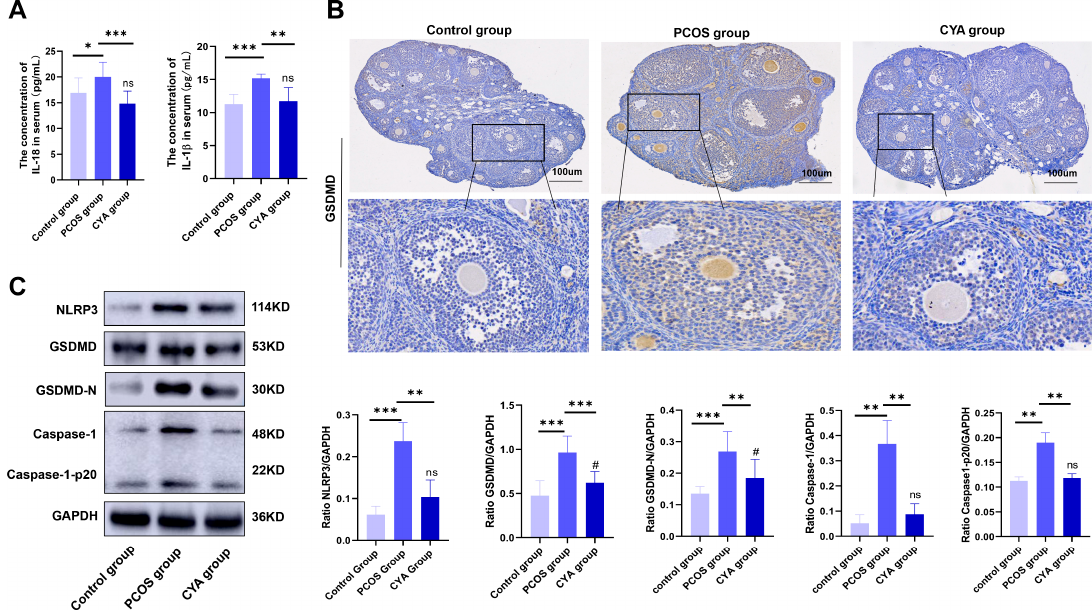
Figure 3. CYA can effectively alleviate the expression of inflammatory factors and ovarian GC pyroptosis-related proteins in PCOS mice induced by hyperandrogen. ( a ) The expression of IL-18 and IL-1 β in serum was analyzed with enzyme-linked immunosorbent assay kits in the three groups of mice; ( b ) the expression of GSDMD in ovaries was assessed with immunohistochemical tests; ( c ) the expression of NLRP3 and pyroptosis-related protein in ovaries was assessed with Western blot. Two independent experiments were performed with similar results. Data are shown as mean ± SEM. “*” represents comparison between groups, “#” indicates the treatment group compared to the control group,“ns” indicated that there was no statistical difference between the treatment group and the control group. * /# p < 0.05, **/## p < 0.01, ***/### p < 0.001.